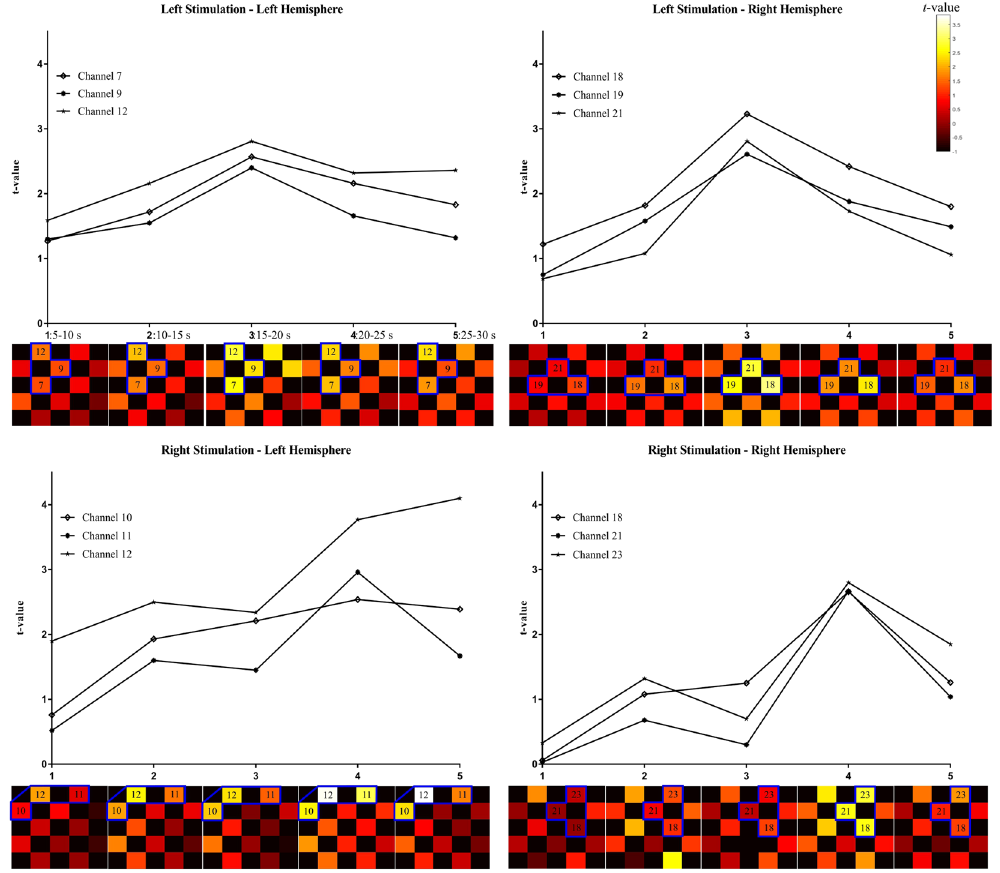
Figure 4. Temporal dynamics of t -values of channel clusters (HbO average of temporal window vs. baseline) plotted separately per condition (left-sided stimulation top figures, right-sided stimulation bottom figures) and hemisphere (left, right). The upper part of each subfigure displays the t -values of those channels that were most clustered, whereas the lower part displays the t -map of the respective time